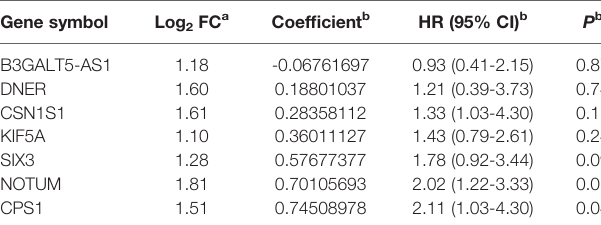
TABLE 2 | Genes included in the seven-gene prognostic